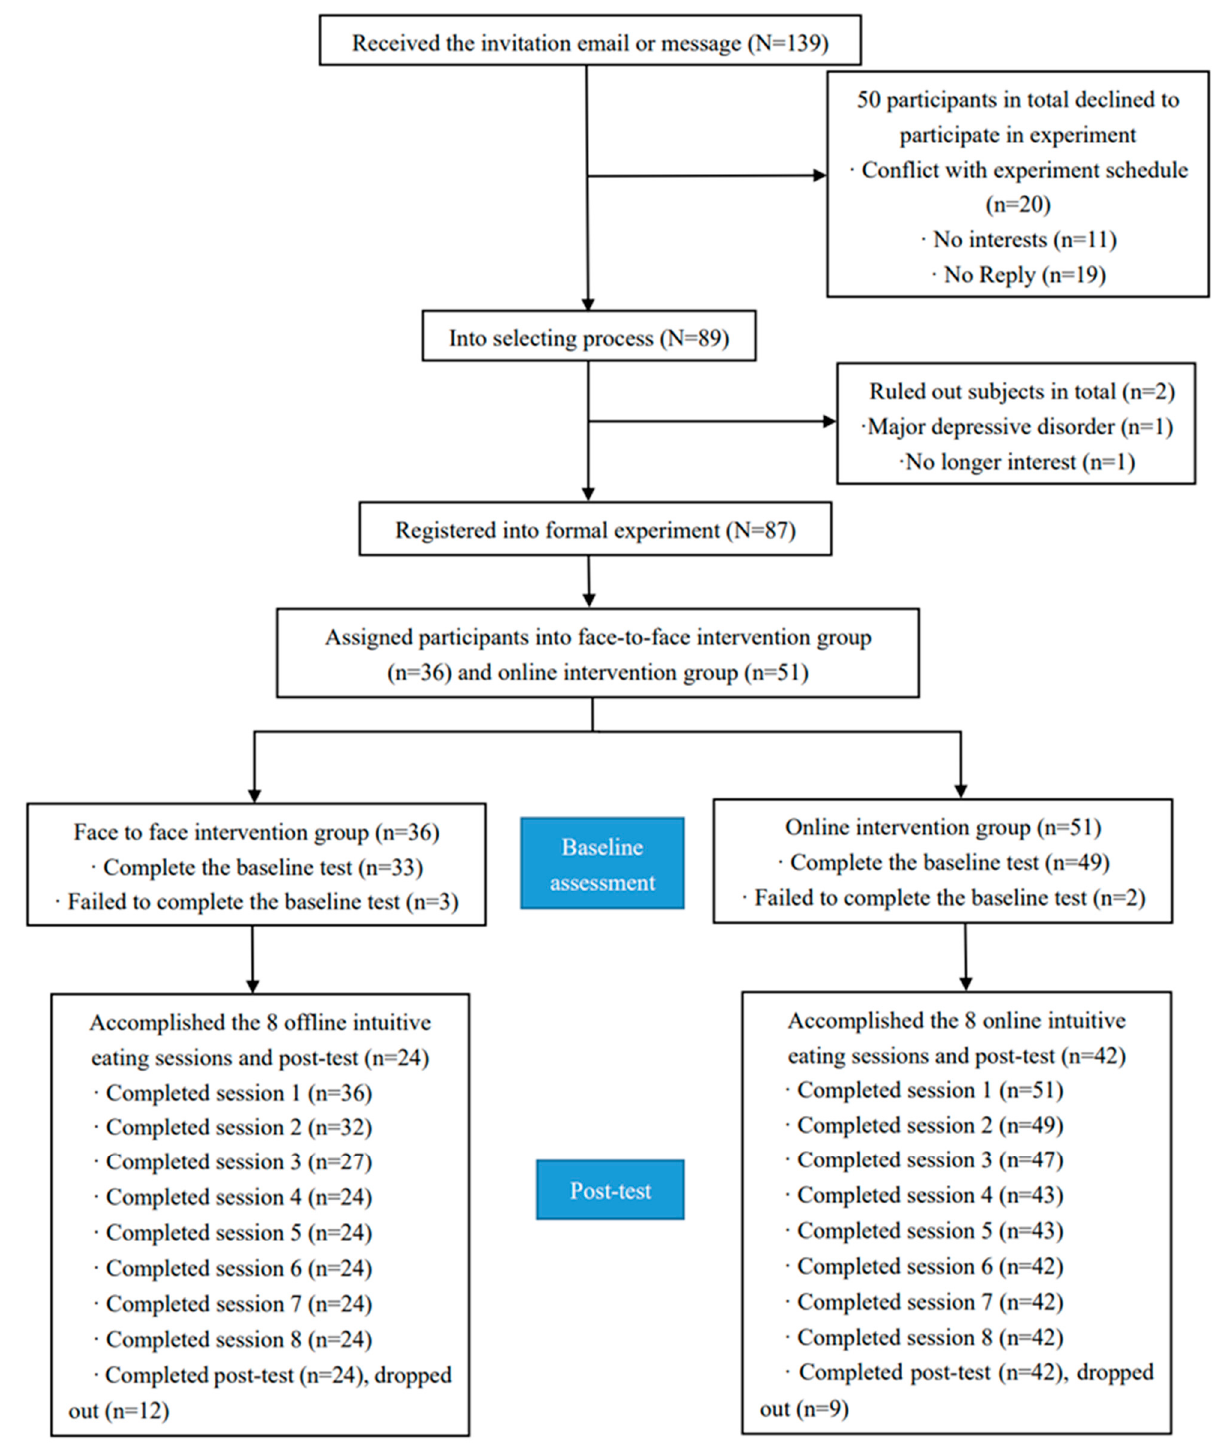
Figure 1. Flow of Study Participation.